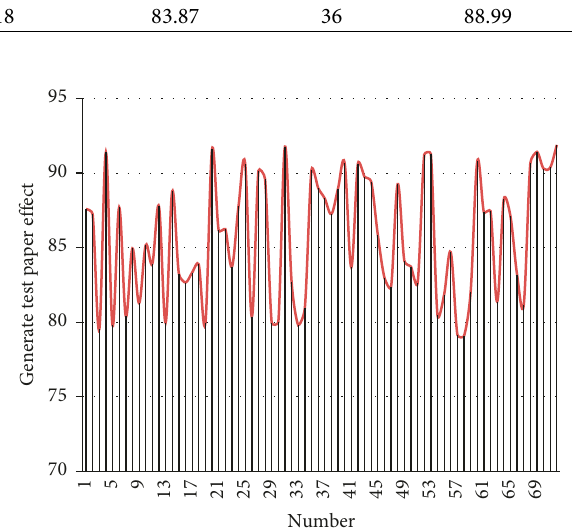
Figure 9: Statistical diagram of system effect